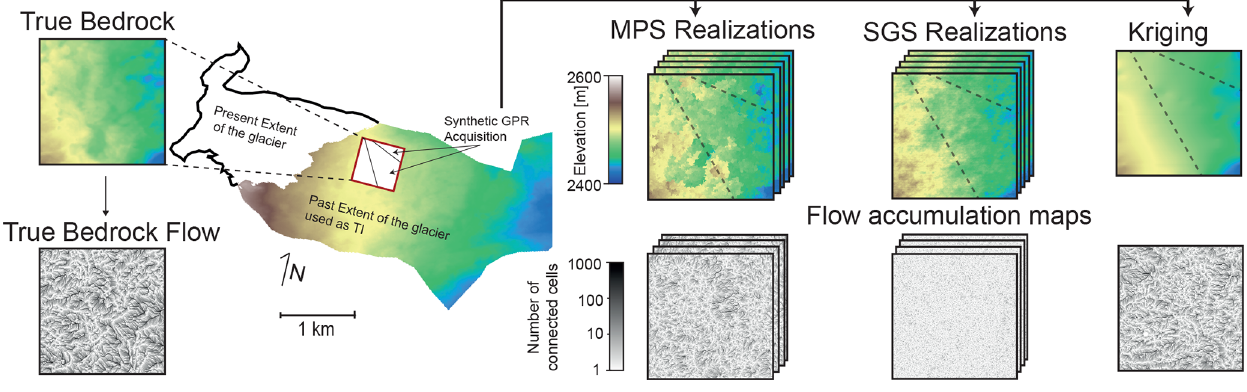
Figure 4. The approach used for the systematic tests. Test zones are extracted from the exposed glacier bedrock. GPR lines are also ex- tracted from these zones and used to constrain the geostatistical simulations. It is then possible to compare the different sets with the actual topography. Flow accumulations maps are calculated from the simulated topography and from the reference extracted DEM for